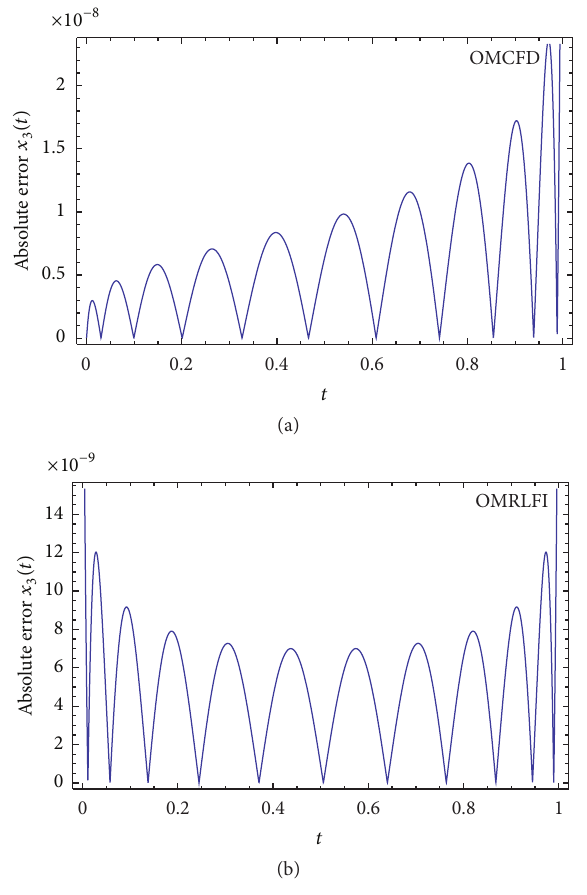
Figure 14: Plot of absolute error function 𝑥 3 (𝑡) for 𝛼 1 = 𝛼 2 = 𝛼 3 = 1 and 𝑚 = 10 by OMCFD and OMRLFI in Example